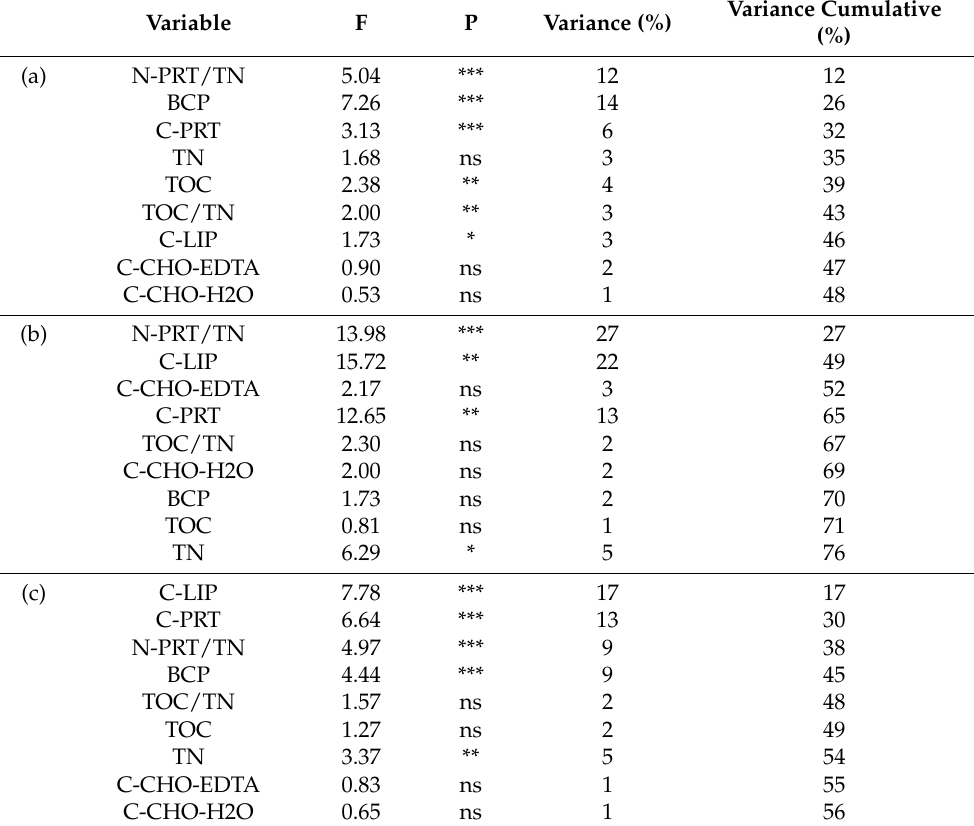
Table 5. Results of the DISTLM forward analyses conducted in order to evaluate the role of different sedimentary organic matter variables on (a) abundance; (b) biodiversity and (c) species composition of the foraminiferal assemblages for all the collected cores. (ns = not significant; * p < 0.05, ** p < 0.01; *** p <